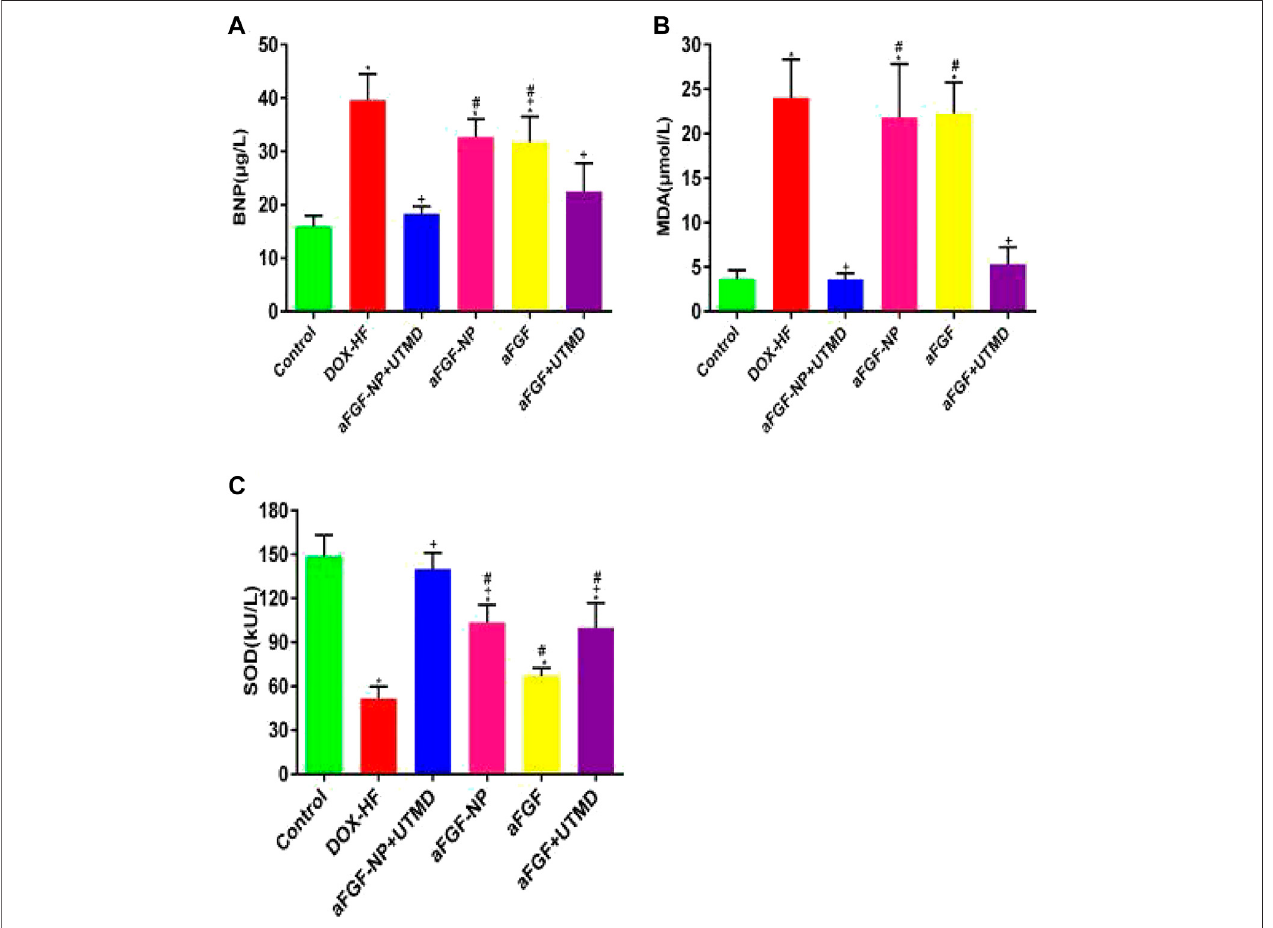
FIGURE 3 | The levels of BNP in the serum (A) , MDA and SOD in myocardial tissue (B, C) were shown in each group. All data are expressed as mean ± SEM. * p < 0.05 vs. Control group; + p < 0.05 vs. DOX – HF group; # p < 0.05 vs. aFGF-NP + UTMD group. aFGF, acidic fi broblast growth factor; NP, nanoparticles; UTMD, ultrasound targeted microbubble destruction; DOX, doxorubicin; HF, heart failure; BNP, brain natriuretic peptide; MDA, malondialdehyde; SOD: superoxide dismutase. Improvement of myocardial histopathology in DOX –